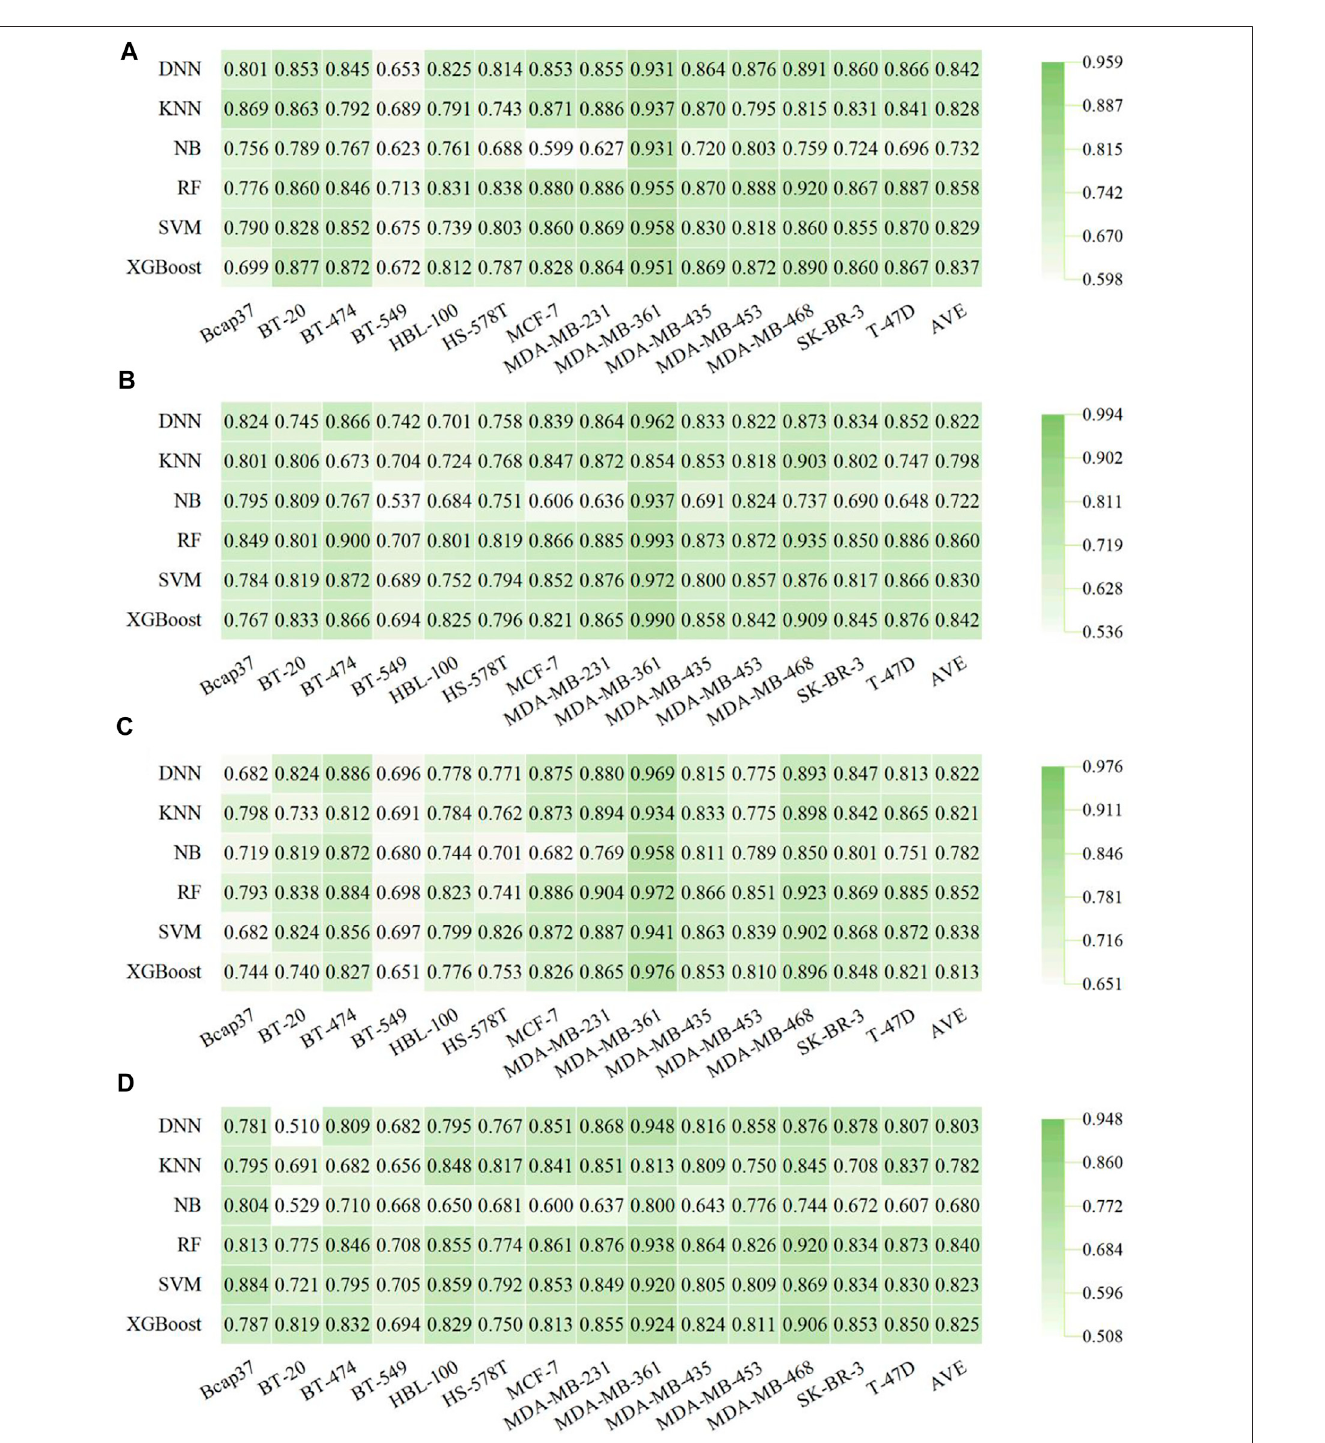
shows that the Attentive FP models performed the best in six breast cancer cell lines including Bcap37, MCF-7, MDA-MB-453, MDA- MB-468, SK-BR-3, and T-47D, making it the most frequent choice.